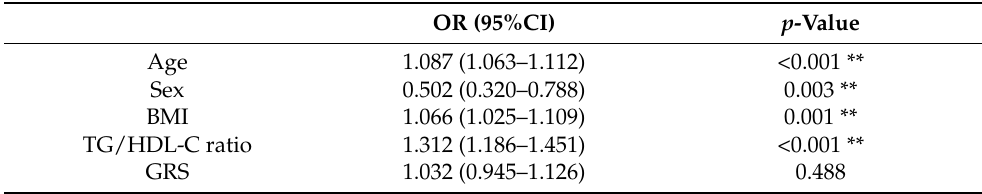
Table 4. Association of genetic risk scores (GRS) with T2DM status (person with fasting glucose levels of less than 5.6 mmol/L vs. fasting blood glucose levels of 7 mmol/L or higher and/or was under antidiabetic treatment) in the Hungarian general population. The association was evaluated under an adjusted regression model (by age, sex, BMI, and TG/HDL-C ratio). OR (95%CI) p